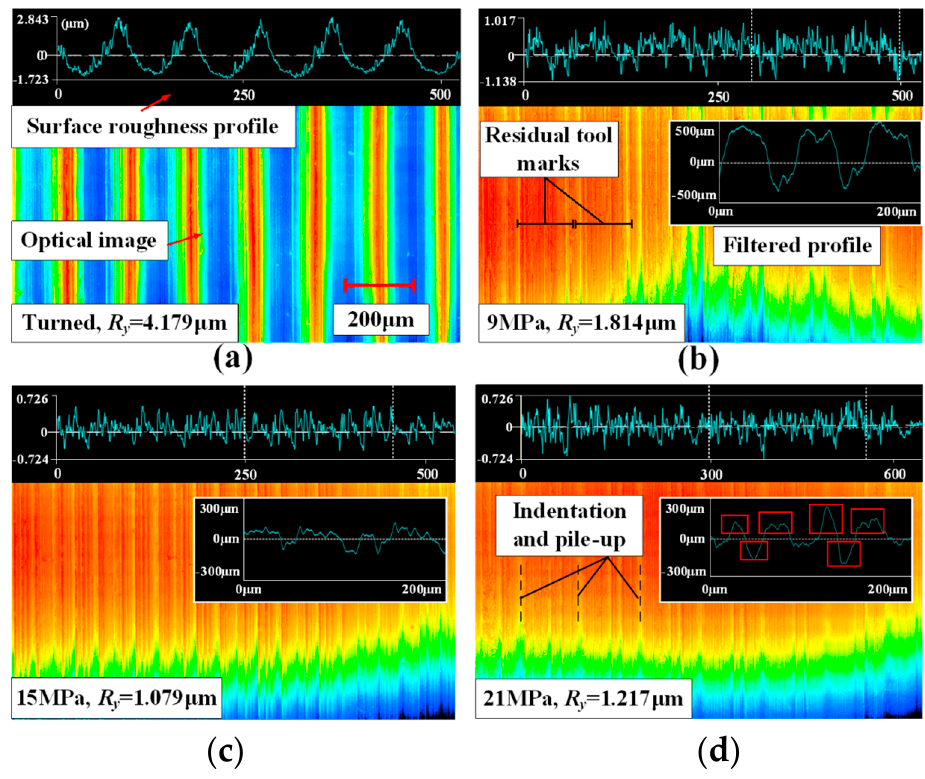
Figure 10. Surface topography of machined Inconel 718. ( a ) Turned, ( b – d ) LPBed under different pressures of 9 MPa, 15 MPa, 21 MPa, respectively.